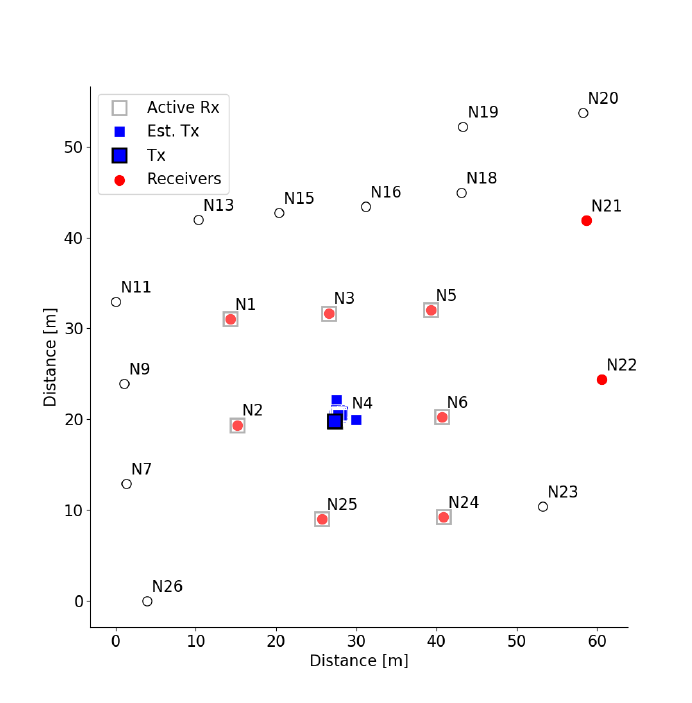
Figure 5. Node location estimated using RSSI BLE